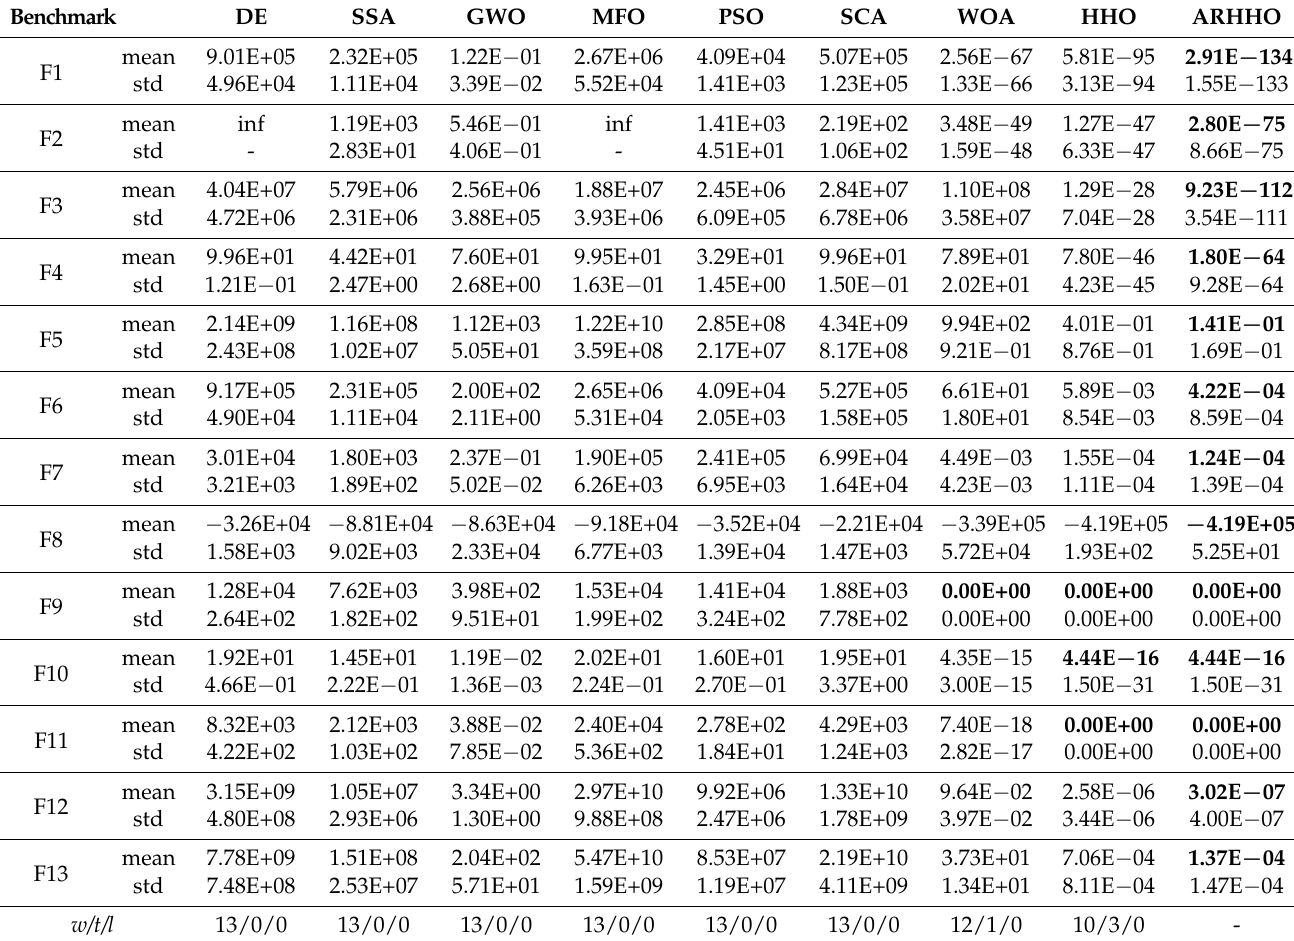
Table 5. Experimental results of benchmark functions F1~F13 in 1000